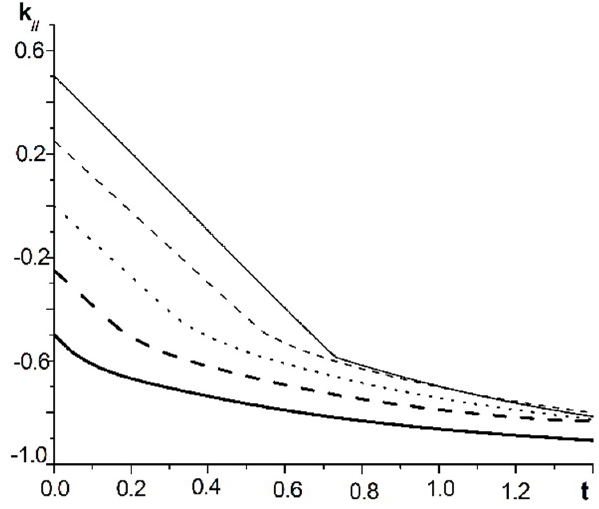
Fig. 2. Wave vector components aligned with the local magnetic field as functions of dimensionless time for the same five rays as in Fig. 1.